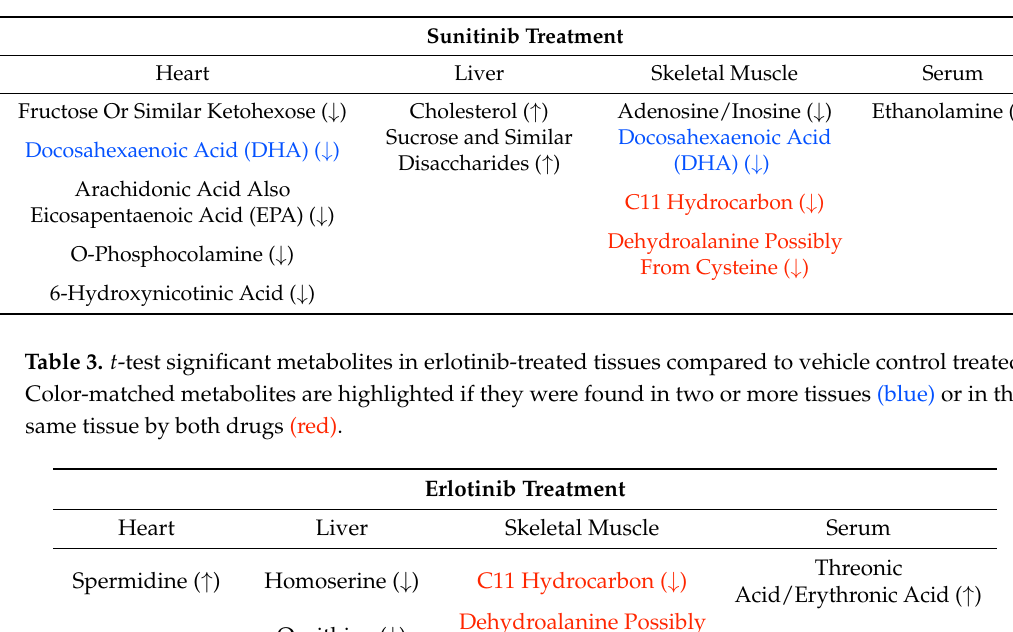
Table 2. t -test significant metabolites in sunitinib-treated tissues compared to vehicle control treated. Color-matched metabolites are highlighted if they were found in two or more tissues (blue) or in the same tissue by both drugs (red).